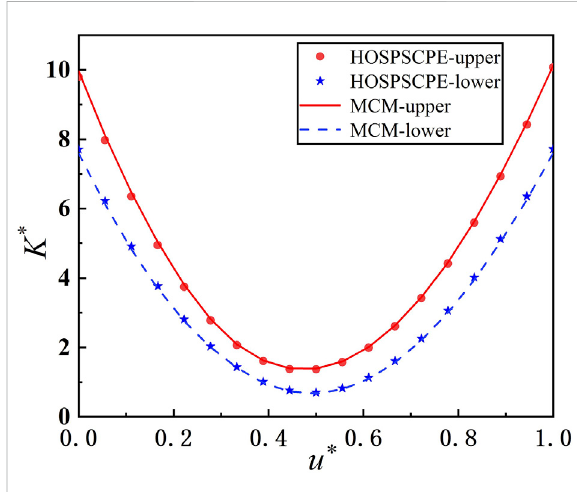
FIGURE 3 The stiffness characteristics of the QZS microstructure with 2% uncertainty obtained by the HOSPSCPE method and the